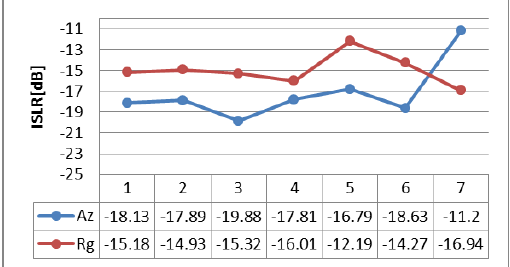
Figure 20. KOMPSAT-5 SAR ISLR assessment